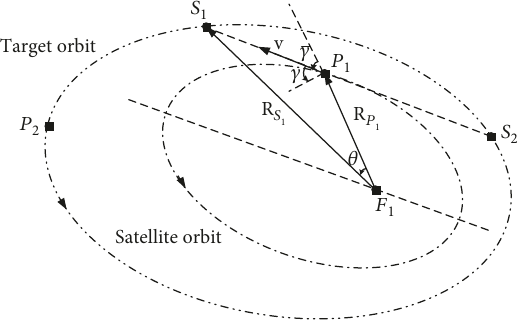
Figure 1: The existence condition of the tangent impulse interception